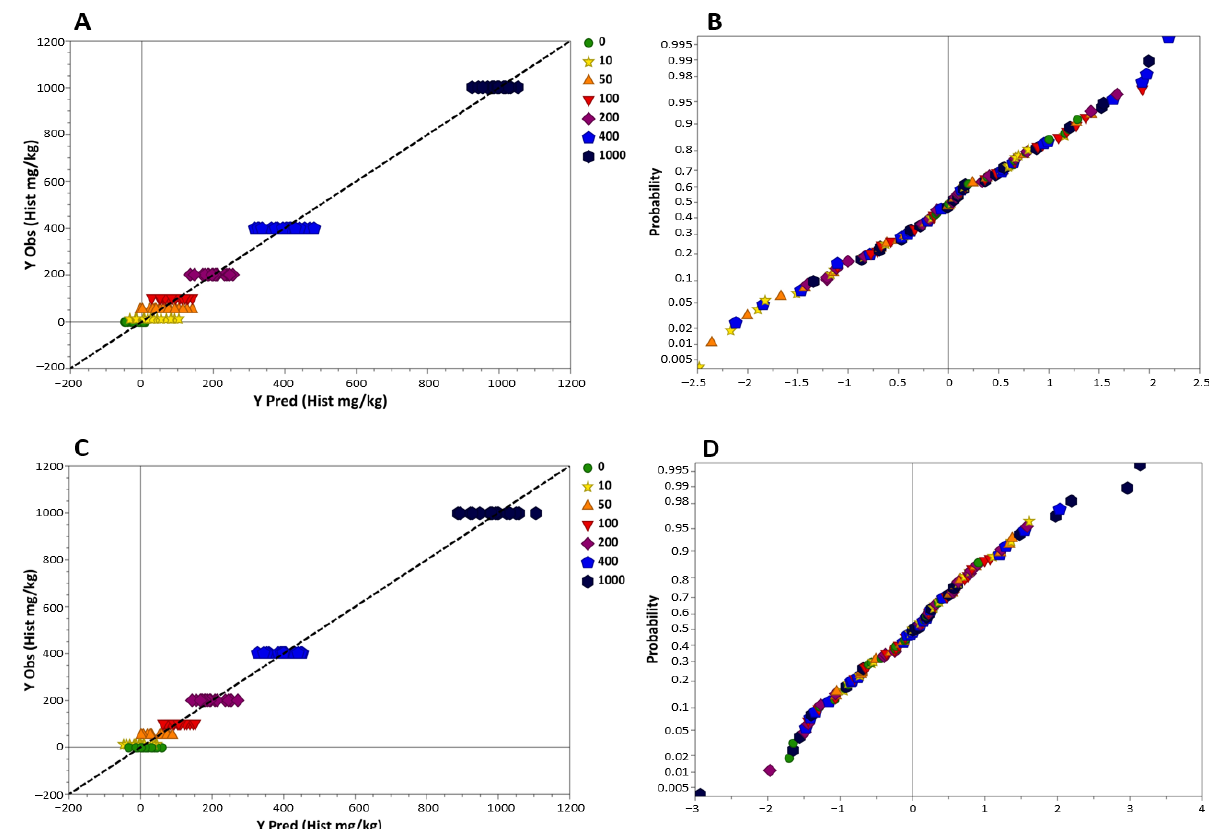
Figure 2. NIR-predicted vs. observed (actual) histamine values in the calibration regression model for raw tuna fish ( A ) and processed tuna fish ( C ) and relative residual normal probability plot ( B , D ). Histamine concentrations: green circles, blanks (mg kg −1 ); yellow stars, 10 mg kg −1 ; orange triangles, 50 mg kg −1 ; inverted red triangles, 100 mg kg −1 ; purple diamonds, 200 mg kg −1 ; blue pentagons, 400 mg kg −1 ; black hexagons, 1000 mg kg −1 . Table 1. Main quantitative and qualitative (discriminant) applications of NIR spectroscopy to dif- ferent fish and seafood species.